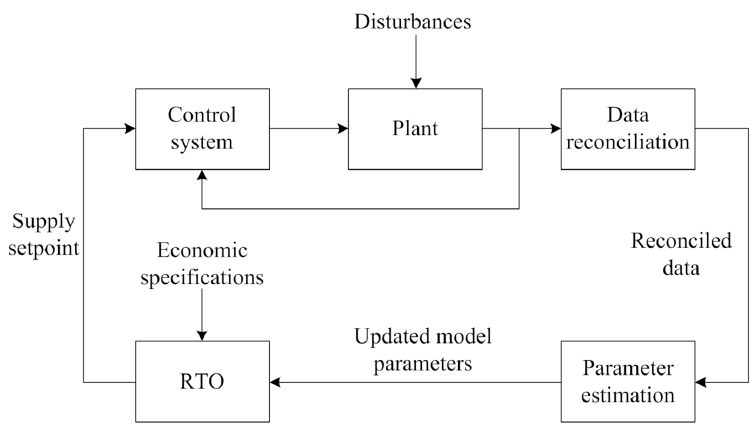
Figure 2. Structure of real-time optimization system.